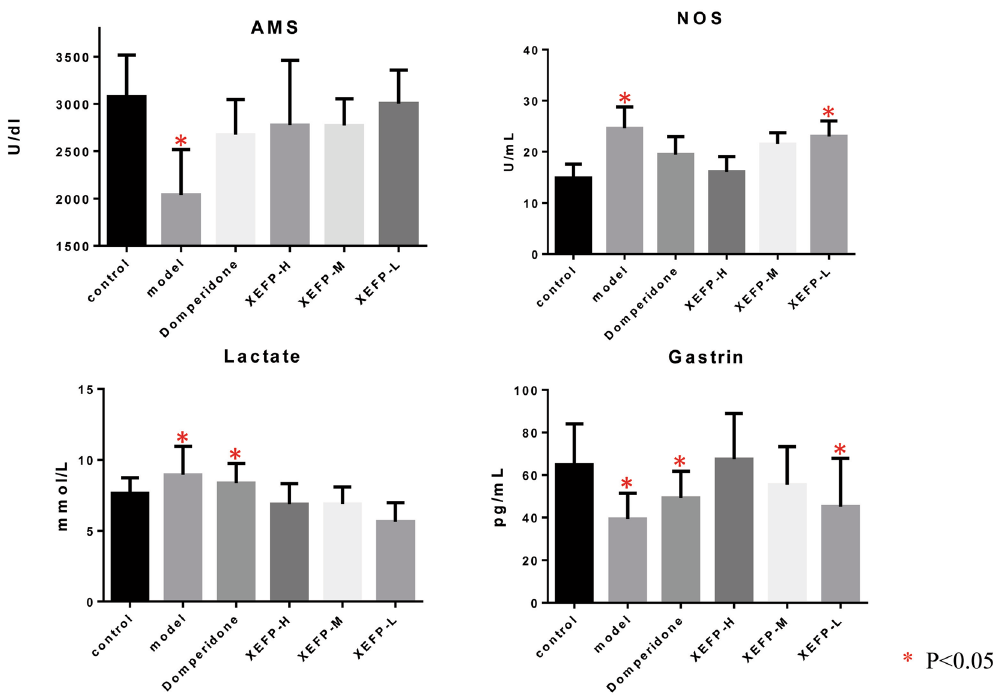
Figure 2. Effects of XEFP on the blood levels of amylase (AMS), lactate, gastrin and nitric oxide synthase (NOS) in FD rats. XEFP-H, high-dosage XEFP. XEFP-M, medium-dosage XEFP. XEFP-L, low-dosage